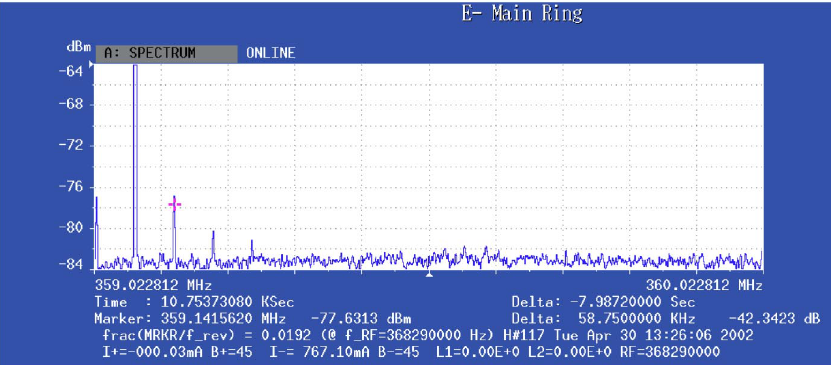
FIG. 9. (Color) Multibunch beam power spectrum showing quadrupole instability (the right sideband is indicated by the cross is 120 kV, and LFB is on. marker). The beam current is (cid:2) 760 mA , V rf